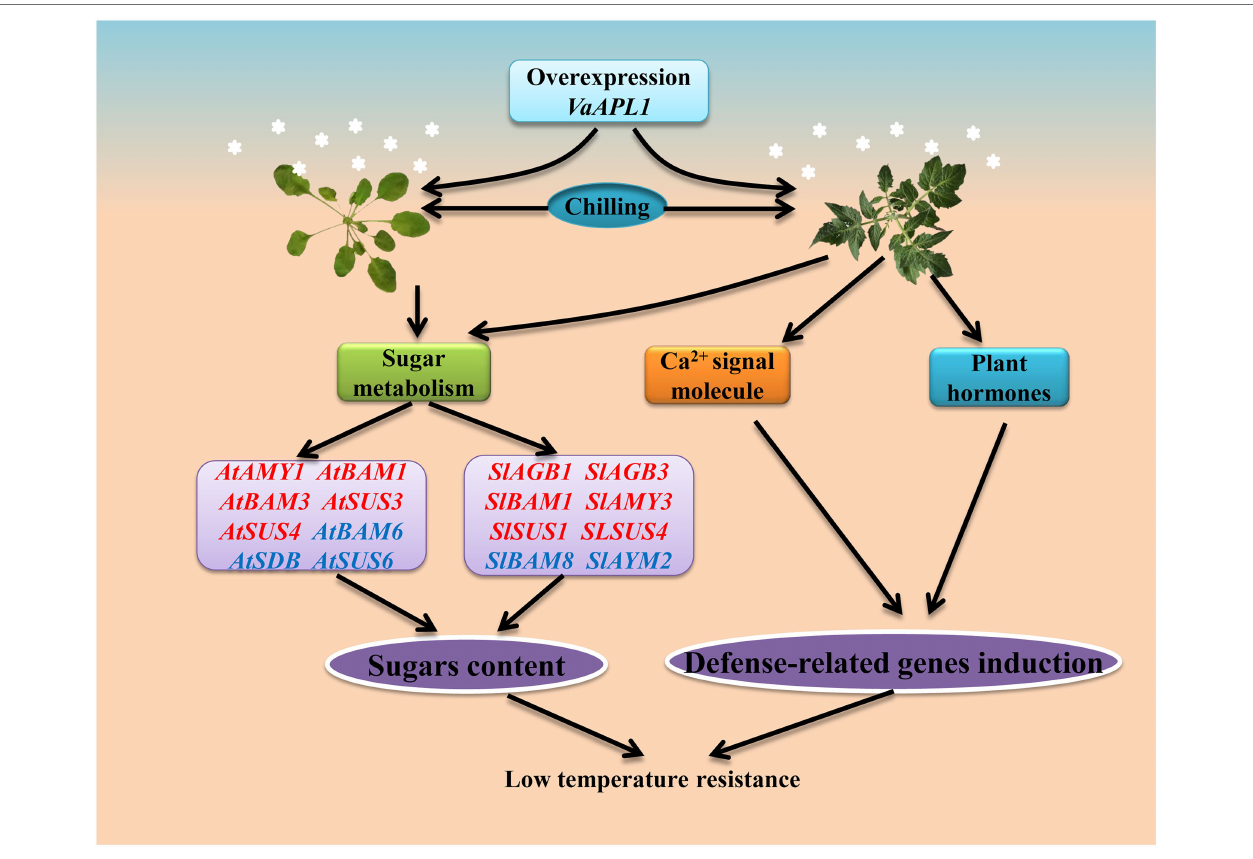
FIGURE 9 | Overexpression of VaAPL1 improved the LT tolerance of A. thaliana and tomato plants. Red and blue colors indicate up- and down-regulated genes, respectively. Briefly, starch degradation and sucrose synthesis-related genes were up-regulated in VaAPL1 -overexpressing A. thaliana plants and OEs after LT stress. The transcriptome data of OEs showed that sucrose and glucose synthesis-related genes were up-regulated during sugar metabolism. Differential expression of these genes increases the contents of sucrose and glucose in OE leaves. Moreover, Ca 2+ signals and hormone signals in OEs also participate in inducing the expression of defense-related genes. These results ultimately enhance the LT tolerance for VaAPL1 -overexpressing A. thaliana plants and